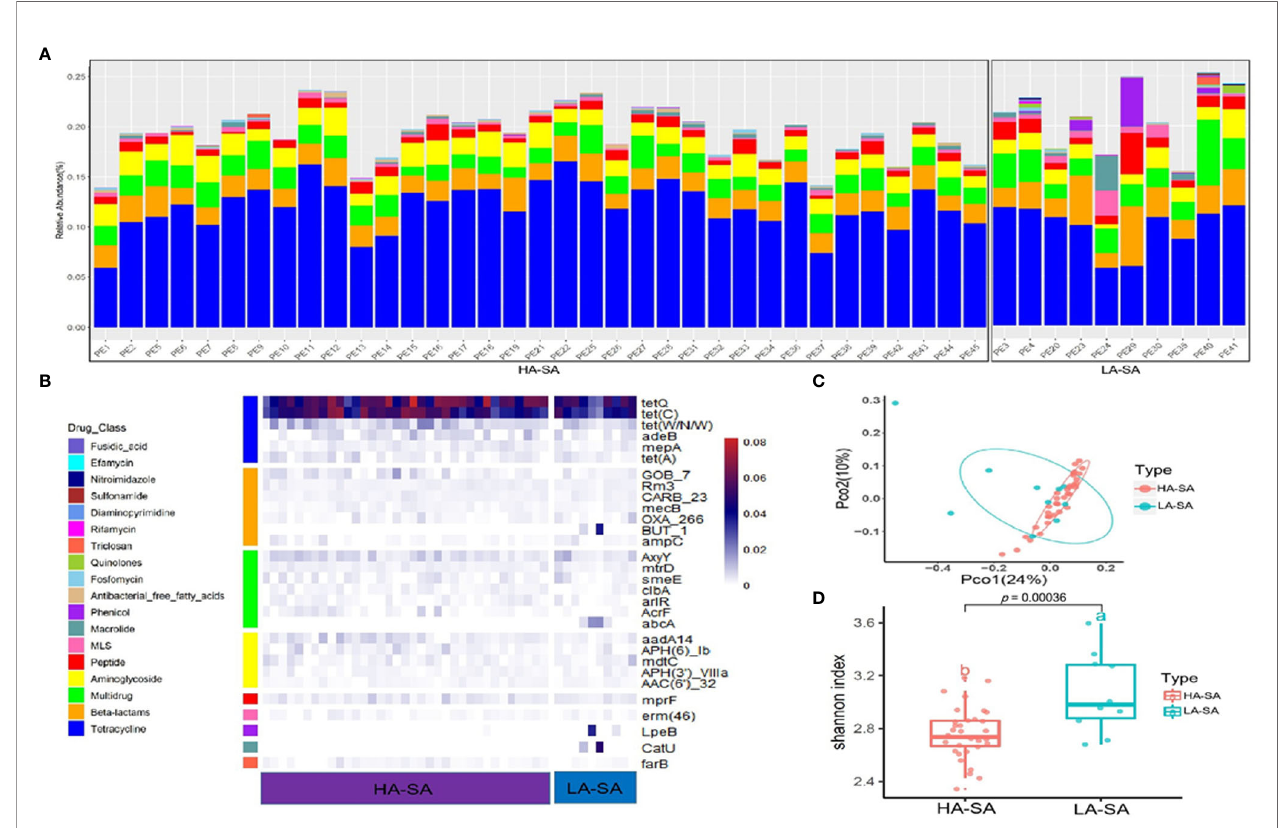
FIGURE 4 | Abundant ARGs in the pleural effusion microbiome. (A) Stacked bar plot of antibiotics resistant classes in the pleural effusion metagenome. (B) The 30 most abundant ARGs in the HA- and LA-SA type were displayed by heatmap. (C) Principal Coordinate Analysis. ARG composition is independent of microbiome community composition. (D) Diversity estimates of detected resistance features. Signi fi cant differences in Shannon diversity estimates of different resistance features of the CARD database inside the HA- and LA-SA